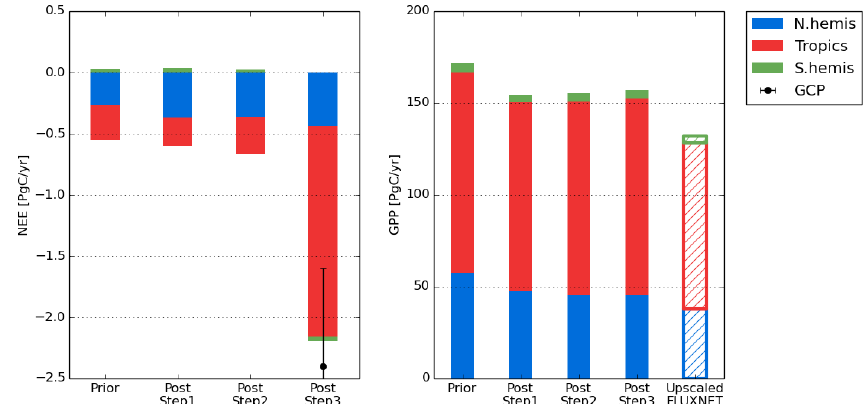
Figure 10. Left: net ecosystem exchange (NEE) for three regions (north of 35 ◦ N, tropics, south of 35 ◦ S) for the prior model, and after each step of the optimizations (mean over 2002–2004). The NEE estimate from the Global Carbon Project (GCP) for the same period (Le Quéré et al., 2015) is provided for step 3 with its error bar. Right: same but for gross primary production (GPP) where the data-driven estimate (MTE product using FluxNet data; Jung et al., 2011) is provided for